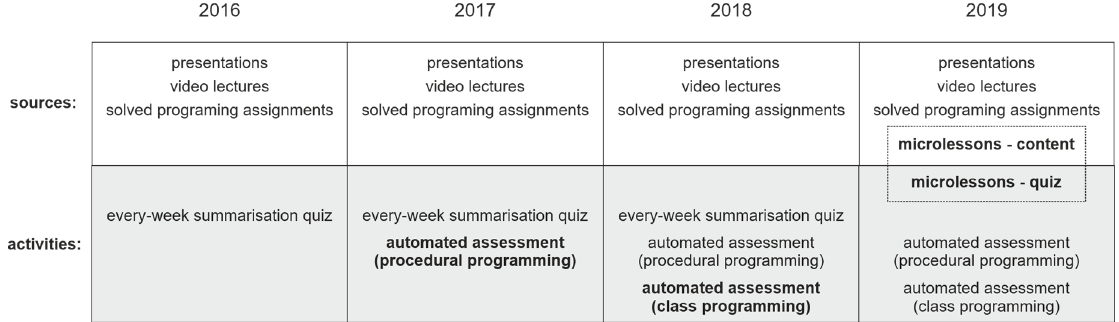
Figure 4. The process of content building—the changes between inspected years.